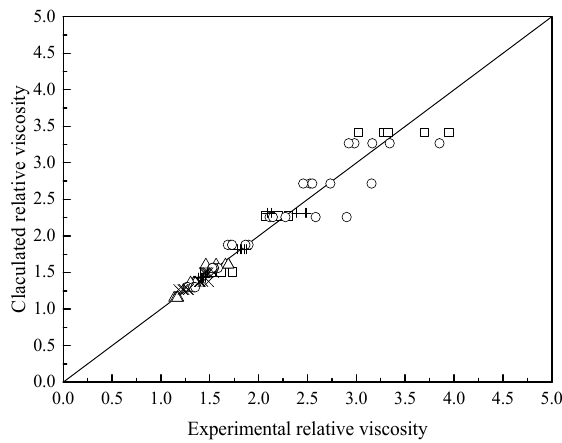
Figure 6. Comparison between the experimental relative viscosity data and calculated values for emulsions with ( □ ) AA-1; ( △ ) AA-2; ( ○ ) AA-3; (×) AA-4; (+) AA-5.